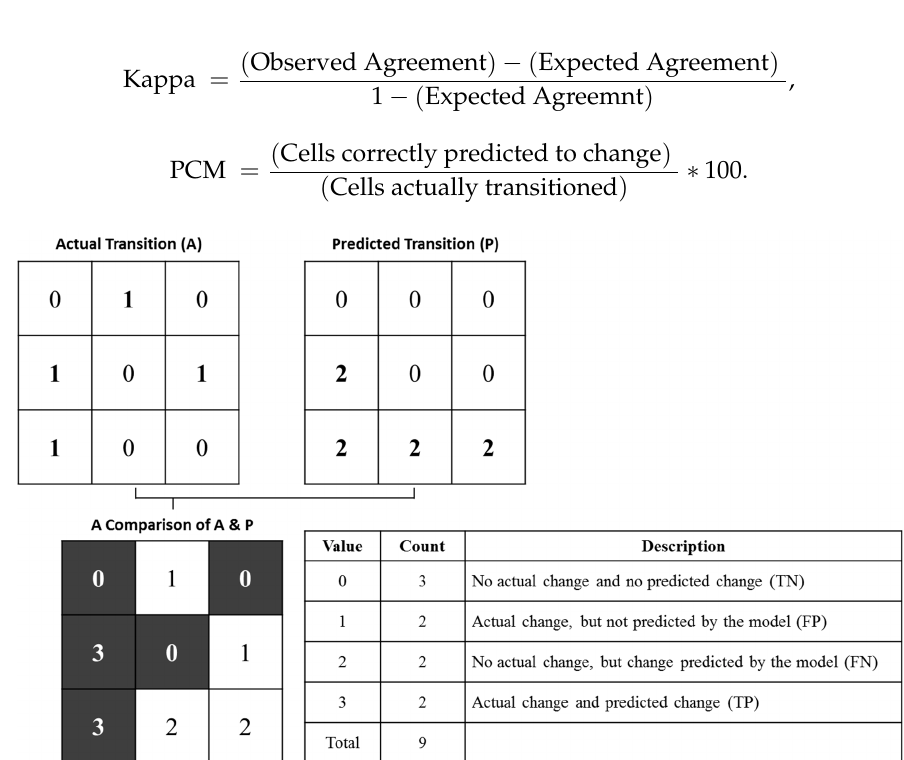
Figure 3. Diagram showing actual transition, predicted transition, and composite score.